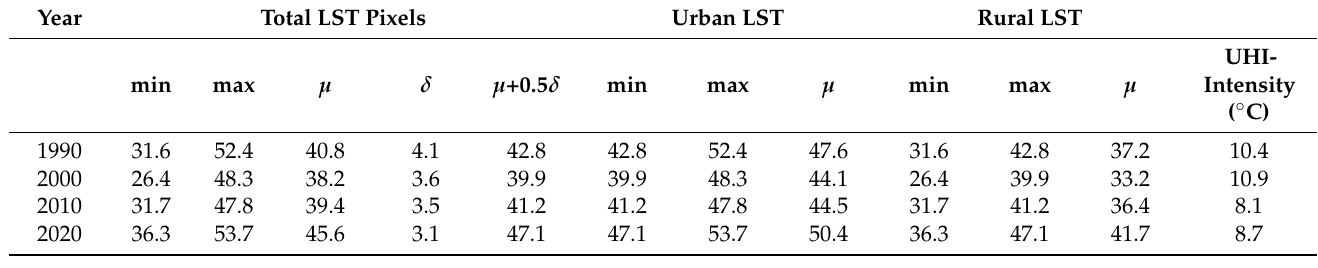
Table 4. The assessment of intensity of UHIs over the multiple surface covers of the study area.